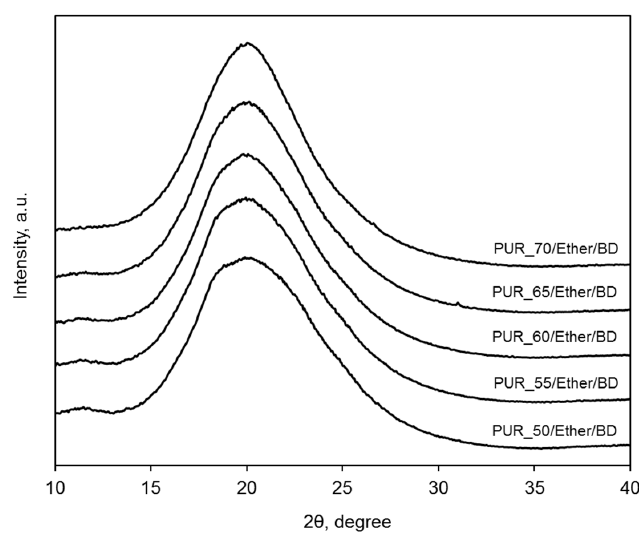
Figure 7. WAXS patterns of PUR with the different contents of the polyether soft segment.